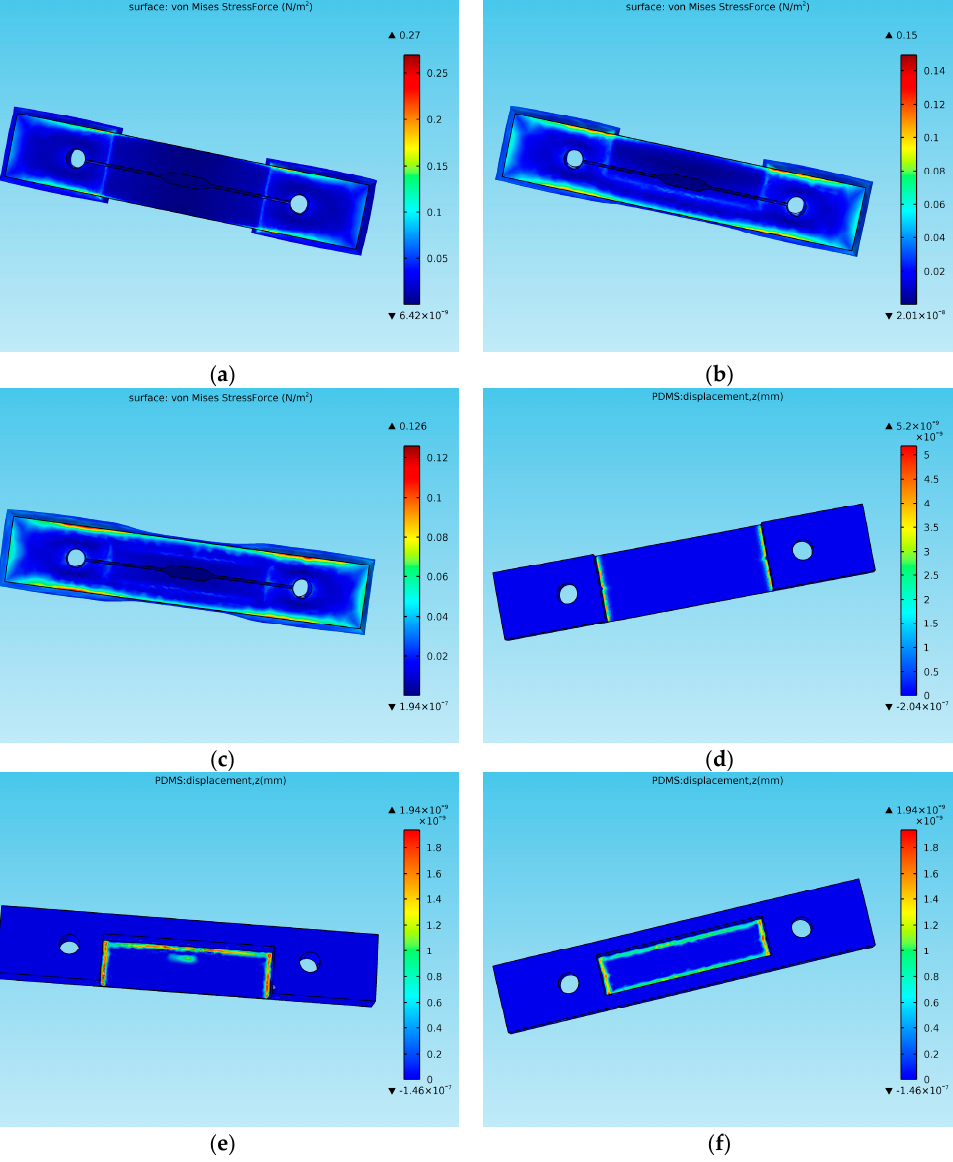
Figure 5. The simulation diagram of the stress and deformation in the z -direction of three kinds of PDMS replica structures in bonding process. Stress of bottom surface of: ( a ) Replica A; ( b ) Replica B; and ( c ) Replica C. Deformation in the z -direction of: ( d ) Replica A; ( e ) Replica B; and ( f ) Replica C.